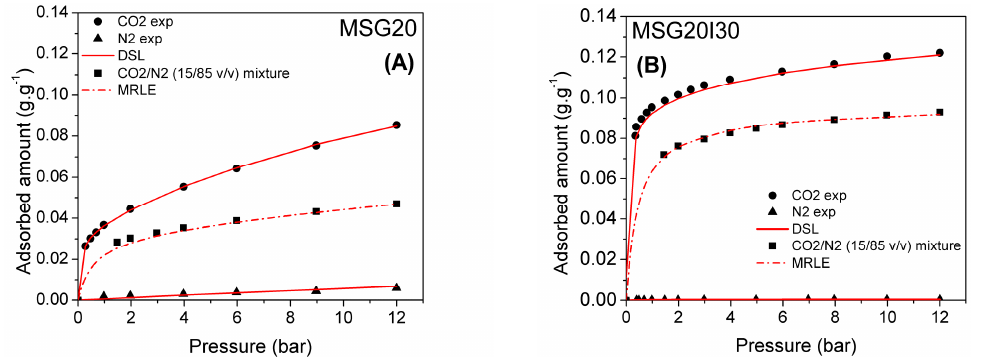
Figure 9. Pure CO 2 and N 2 and binary isotherms (0.15 CO 2 and 0.85 N 2 ) at 50 °C for ( A ) MSG20 and ( B ) MSG20I30 samples, continuous lines are fits to Dualsite Langmuir model, and dashed lines are fits to the Multi Region Langmuir Extended model.